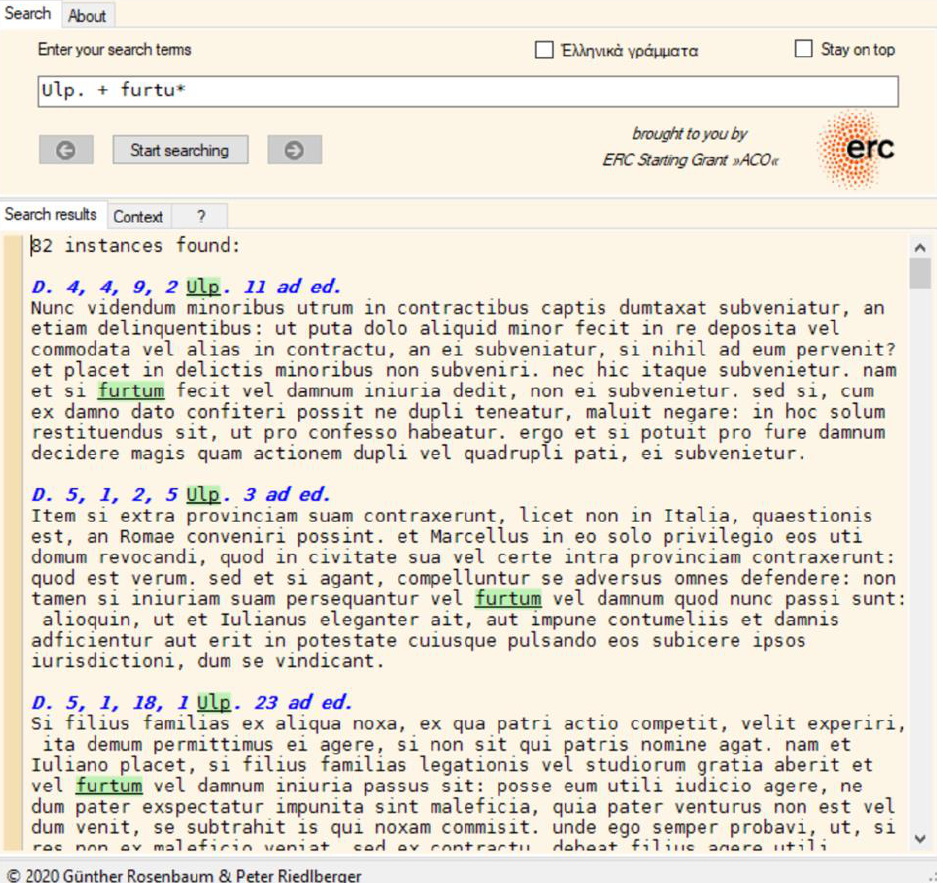
Figure 1. Screenshot of Amanuensis V5.0 displaying texts related to furtum in the works of Ulpian in ROMTEXT.